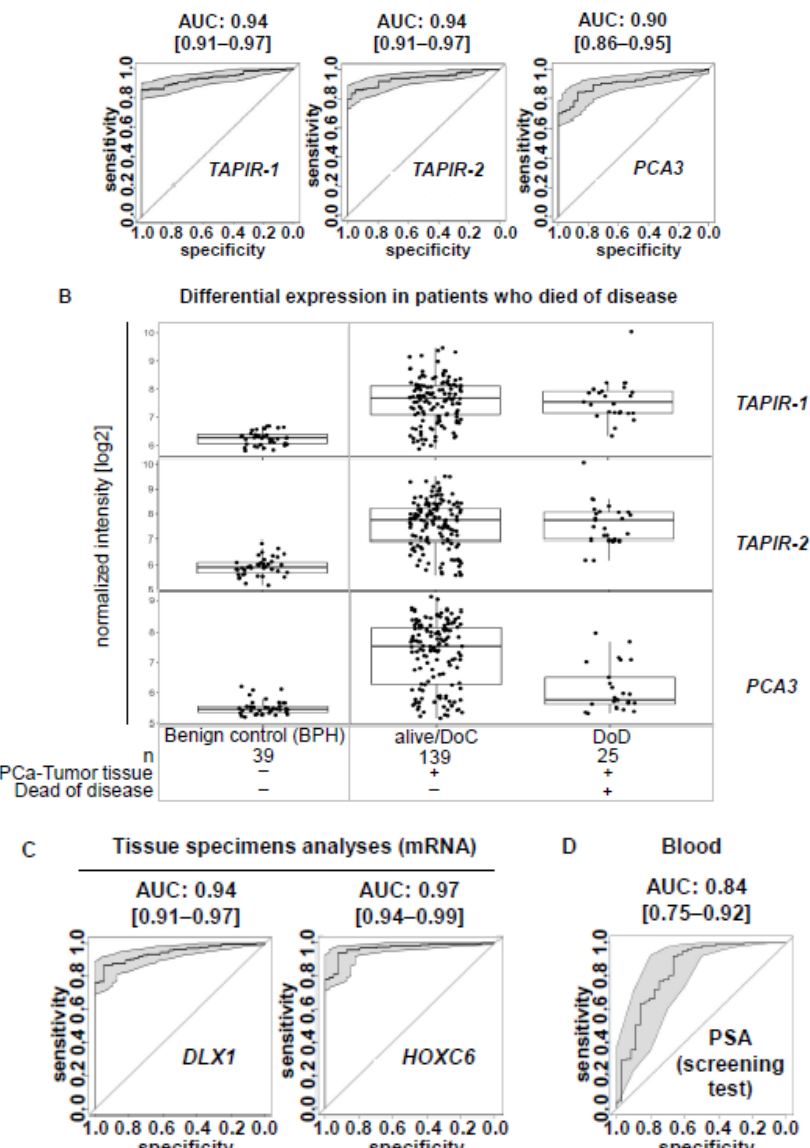
Figure 2. Expression pattern of TAPIR-1 and -2 showing potent diagnostic properties as prostate cancer biomarker in tissue analysis. ( A ) ROC curve analysis for the lncRNAs TAPIR-1 , TAPIR-2 and the clinical PCa biomarker prostate cancer antigen 3 (PCA3) measured using Agilent custom expression microarray analysis of tissue specimens of the validation cohort (tumor tissues from 124 PCa patients and control tissues from 39 BPH patients). All three RNA markers, TAPIR-1 , TAPIR-2 , and PCA3 , revealed high PCa diagnostic AUC values of 0.94 [CI:0.91–0.97] measured by two specific custom probes; FDR